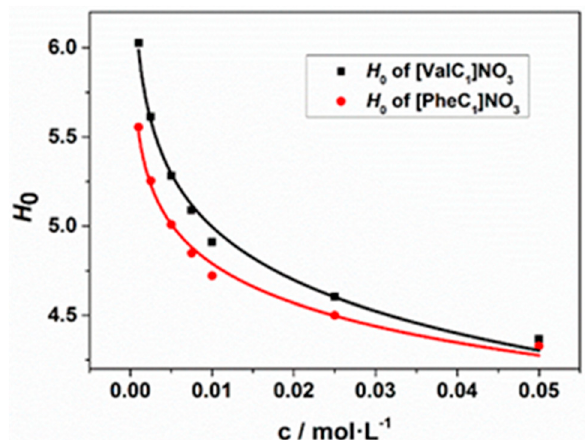
Figure 5. The relationship of [ValC 1 ]NO 3 and [PheC 1 ]NO 3 between the H 0 and concentrations in water at 25.0 (±0.1) °C.